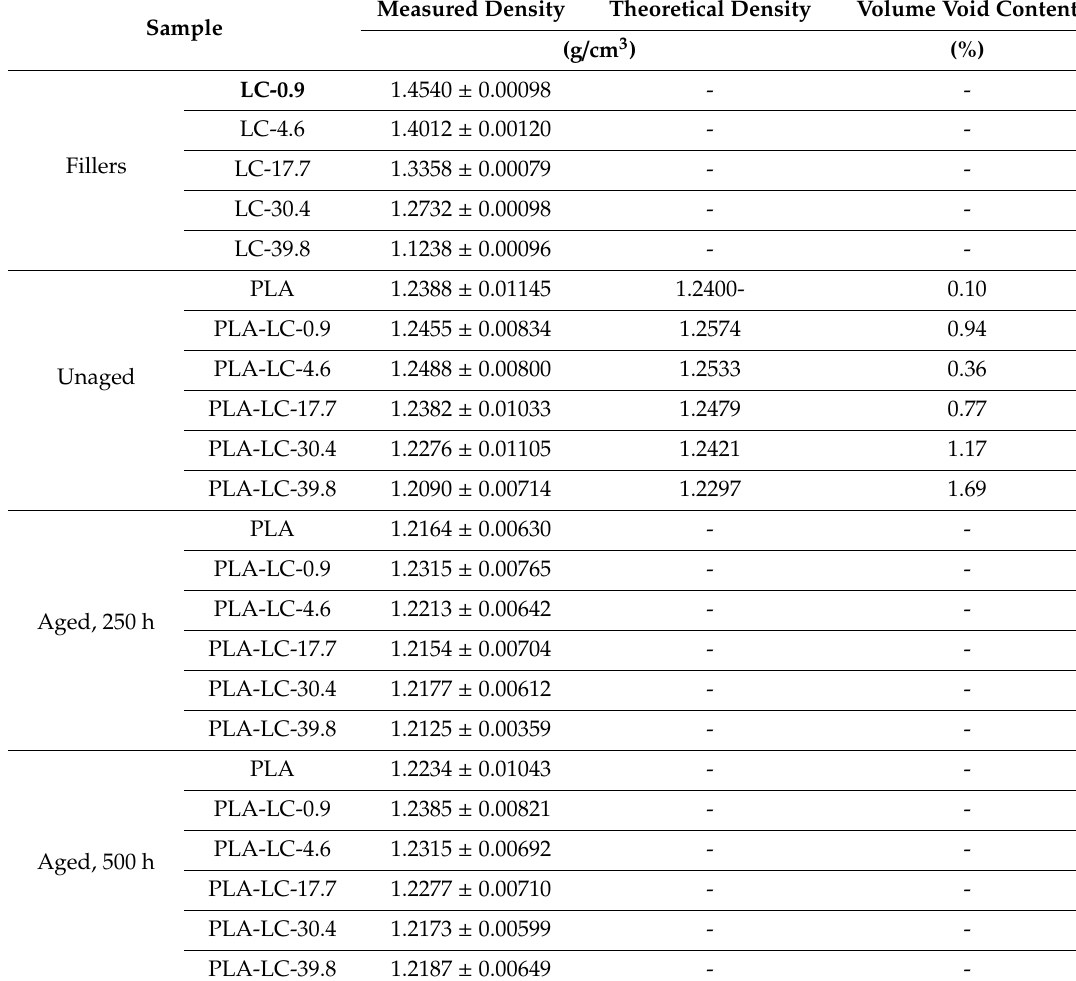
Table 1. Measured and theoretical density and volume void content of the